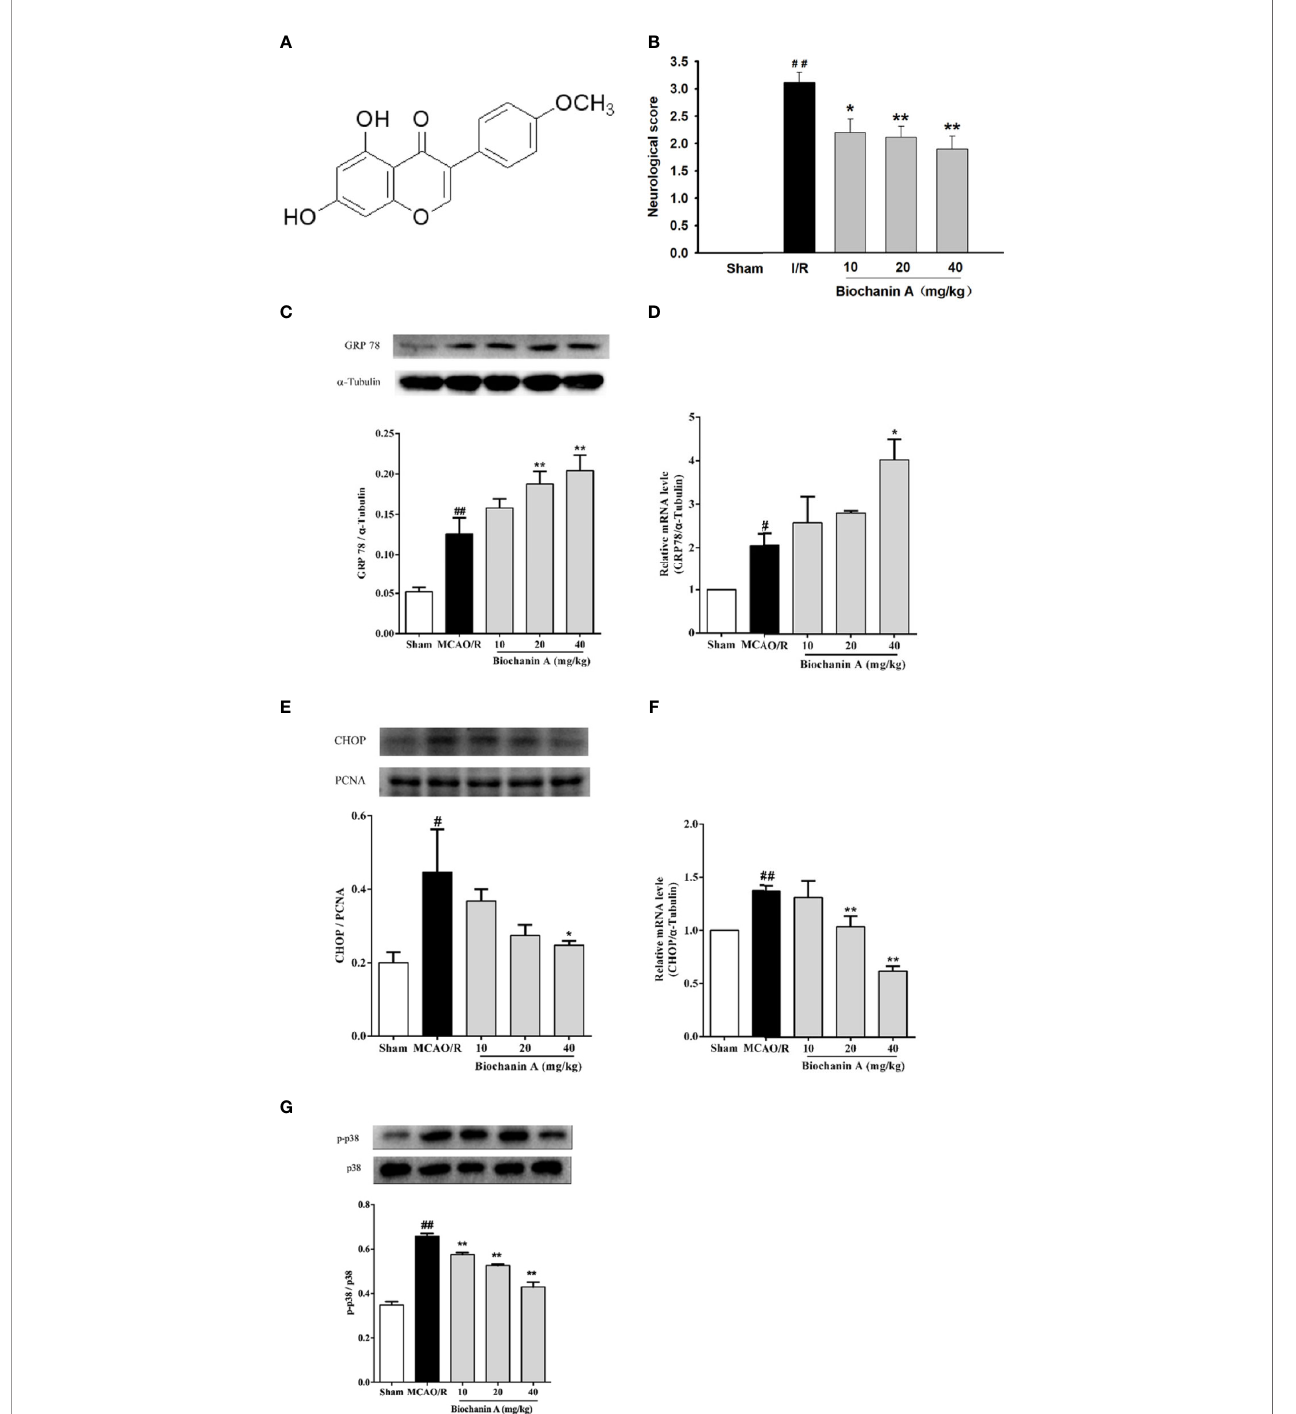
FIGURE 1 | The effects of biochanin A on neuroprotection, attenuating endoplasmic reticulum stress and down-regulating the phosphorylation of p38 expression in MCAO/R rats. (A) The basic structure of biochanin A. (B) Neurological functional de fi cits in rats after MCAO/R were assessed using a 5-point scoring system, n=9- 10. (C) Representative western blot fi gures and quanti fi cation of GRP78 in the rats at 24 h after MCAO/R, n=3. (D) GRP78 mRNA expression level in MCAO/R rats, n=3. (E) Representative western blot fi gures and quanti fi cation of CHOP in the nuclear fractions of brain tissue at 24 h after MCAO/R, n=3. (F) CHOP mRNA expression level in MCAO/R rats, n=3. (G) Effects of biochanin A on the activity of p38 in cerebral I/R rats, n=3. The ratio of p-p38 to total p38 was used to evaluate protein activity. Results were presented as mean ± SE. # P < 0.05, ## P < 0.01, the MCAO/R group vs. the sham group; * P < 0.05, ** P < 0.01, vs. the MCAO/R